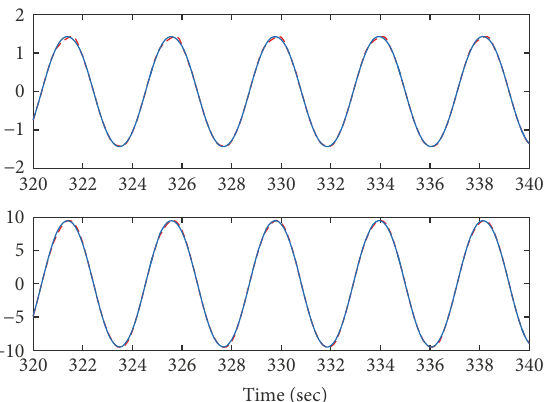
̂𝑊 𝑇 𝑆 (Ψ ) (- -) and ℎ 𝑖 𝑖 𝑖